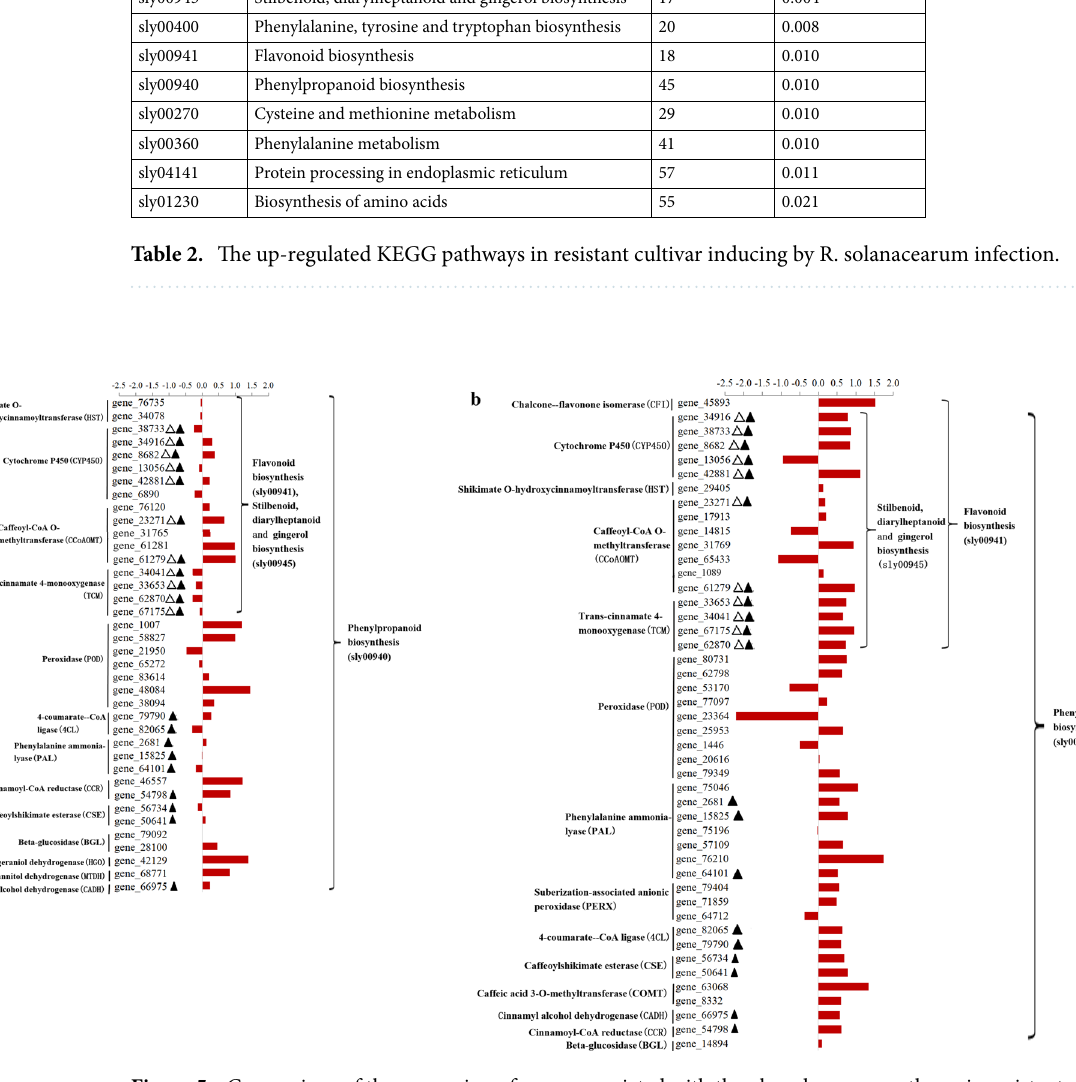
Figure 5. Comparison of the expression of genes associated with the phenylpropane pathway in resistant and susceptible cultivars in response to Ralstonia solanacearum infection. The bar represents log 2 (In-R/In-S), where In-R and In-S are read count values of the gene in resistant and susceptible cultivars induced by R. solanacearum . Comparison of the expression of genes in resistant and susceptible cultivars in response to R. solanacearum infection at 3 dpi ( a ) and 7 dpi ( b ). Δ indicated common differentially expressed genes enriched in the flavonoid biosynthesis and stilbenoid, diarylheptanoid, and gingerol biosynthesis pathway at 3 and 7 dpi. Filled triangle indicated common differentially expressed genes enriched in the phenylpropanoid biosynthesis pathway at 3 and 7